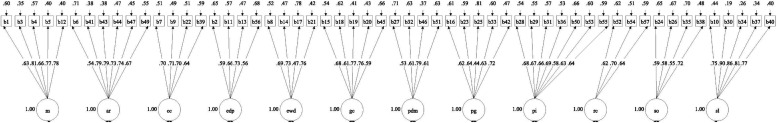
Factorial structure of the SOHQ.